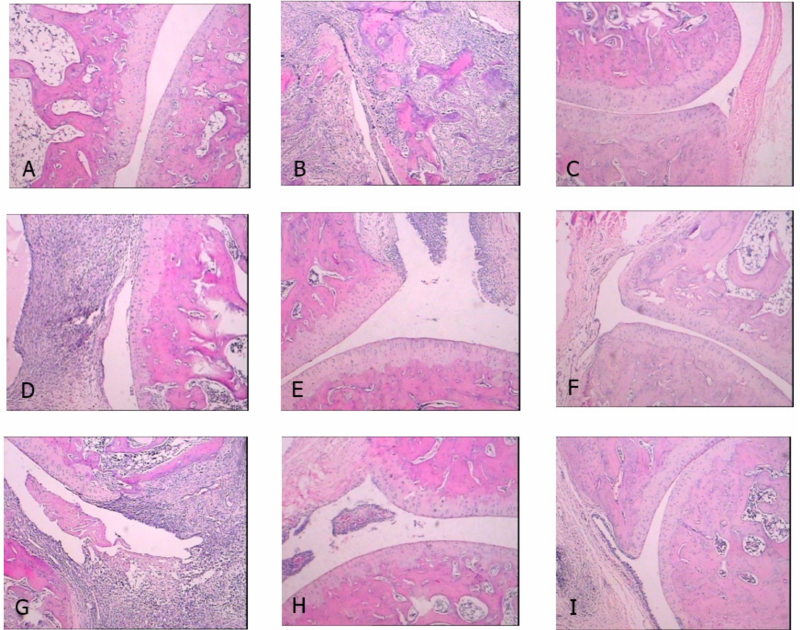
Figure 3. Effects of CDLF and CQAF on histopathological changes of ankle joints in CIA rats at day 28 (40 × , hematoxylin and eosin (H&E) staining). ( A ) Non-treated group; ( B ) CIA-treated control group; ( C ) TGT treated (37.5 mg/kg); ( D ) CQAF treated (125 mg/kg); ( E ) CQAF treated (250 mg/kg); ( F ) CQAF treated (500 mg/kg); ( G ) CDLF treated (125 mg/kg); ( H ) CDLF treated (250 mg/kg); and ( I ) CDLF treated (500